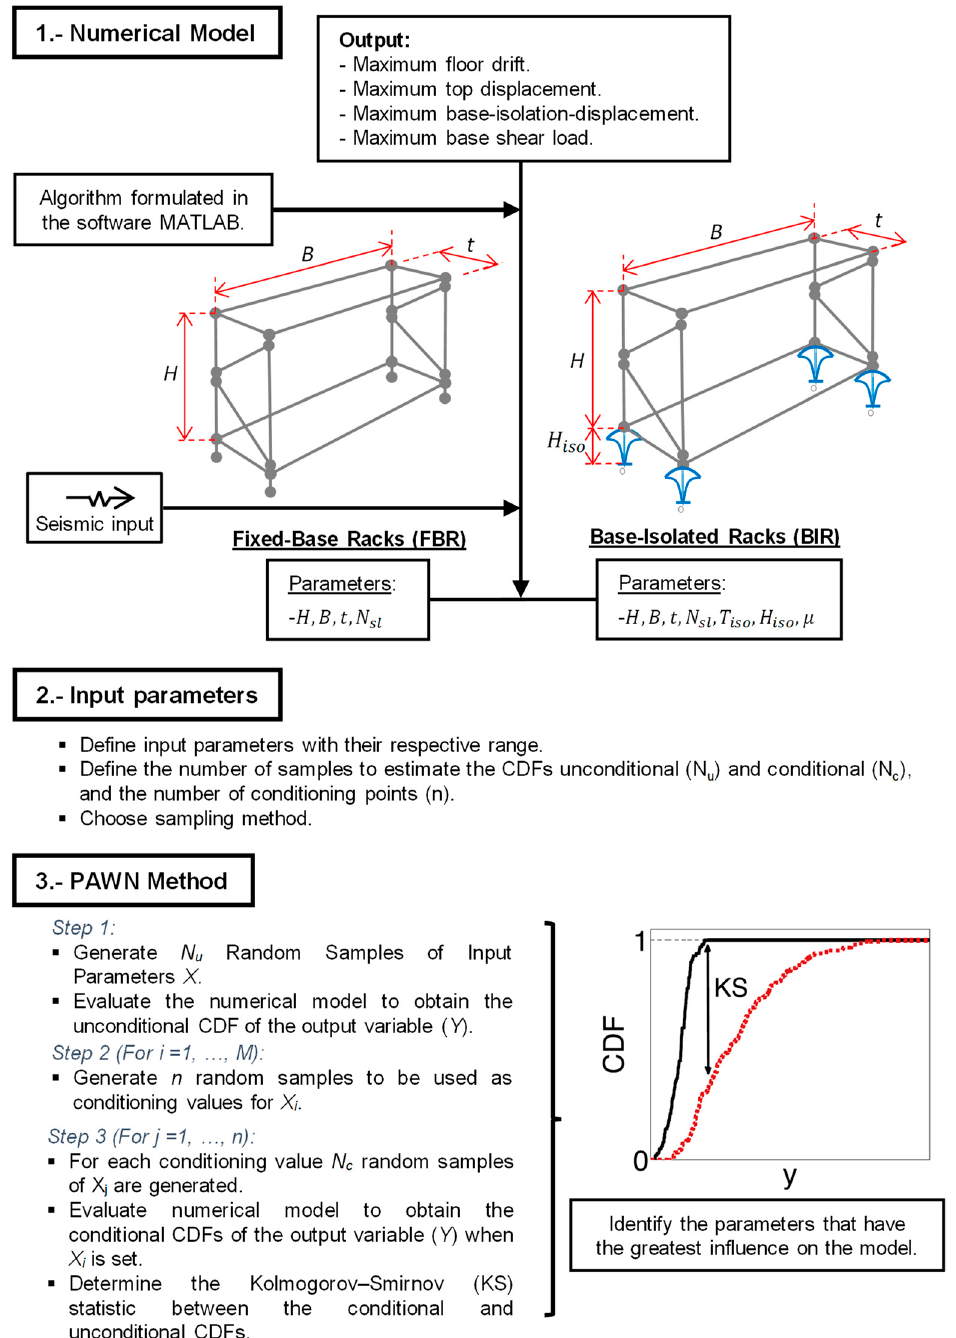
Figure 2. Conceptual model of analysis and flow diagram of the PAWN method.